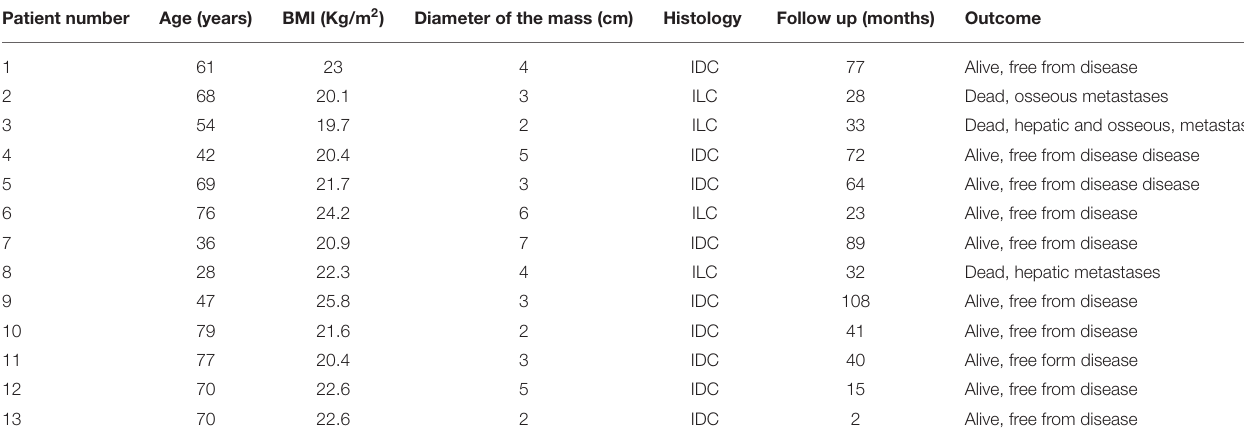
TABLE 1 | Main clinical data of the patient population. Patient number